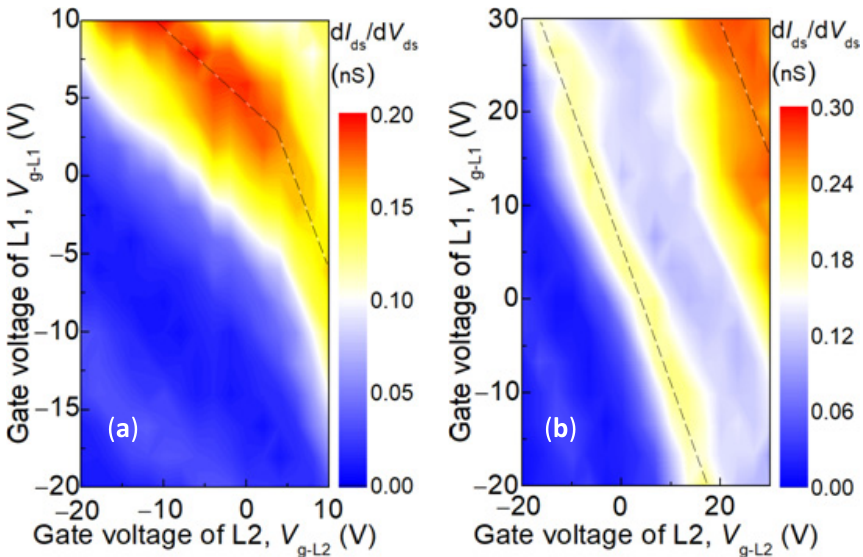
Figure 6. Double quantum dot systems are controlled by gate pressure with different coupling intensities. ( a ) There is capacitive coupling between quantum dots, one electron on one quantum dot changes the electrostatic energy of the other quantum dot; ( b ) The coupling capacitance evolves to the main capacitance, and the separation of the triple point reaches the maximum.